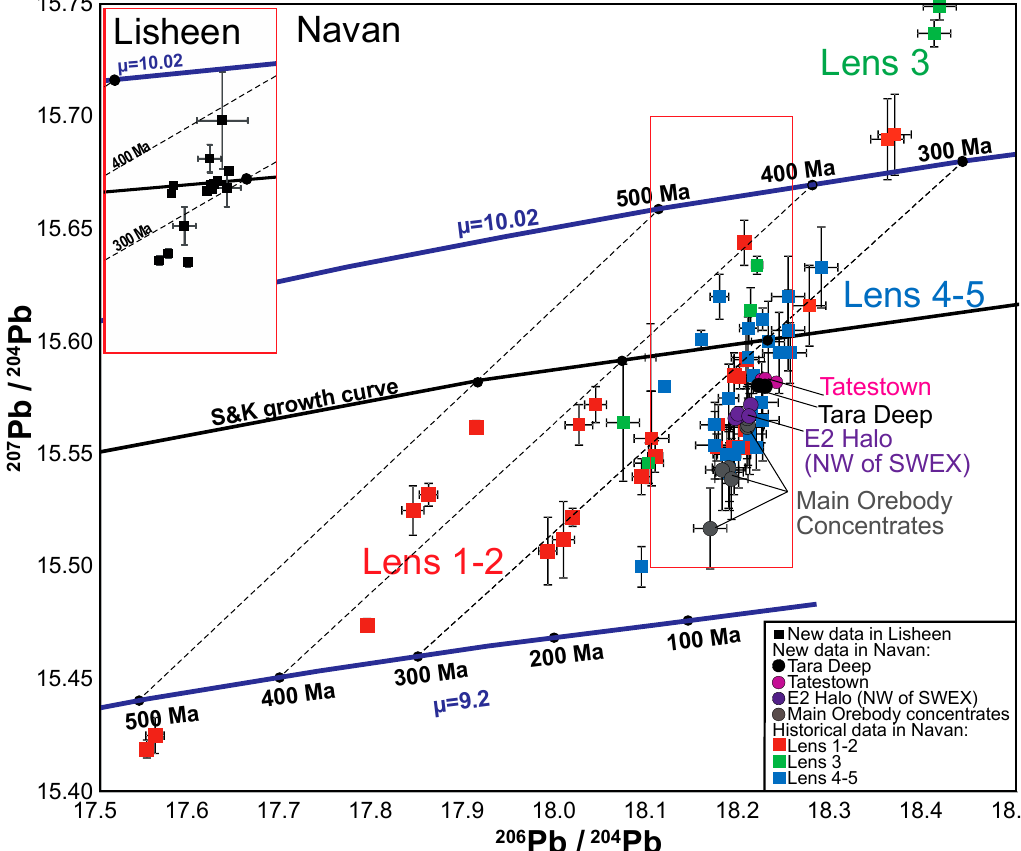
Figure 10. 206 Pb/ 204 Pb and 207 Pb/ 204 Pb isotope constraints from the Navan and Lisheen deposits. New Lisheen data (black squares) are shown inset for clarity, new Navan data as colored circles (range shown by the right-hand red box) and published Navan data as colored squares [17,21,24,51–53].